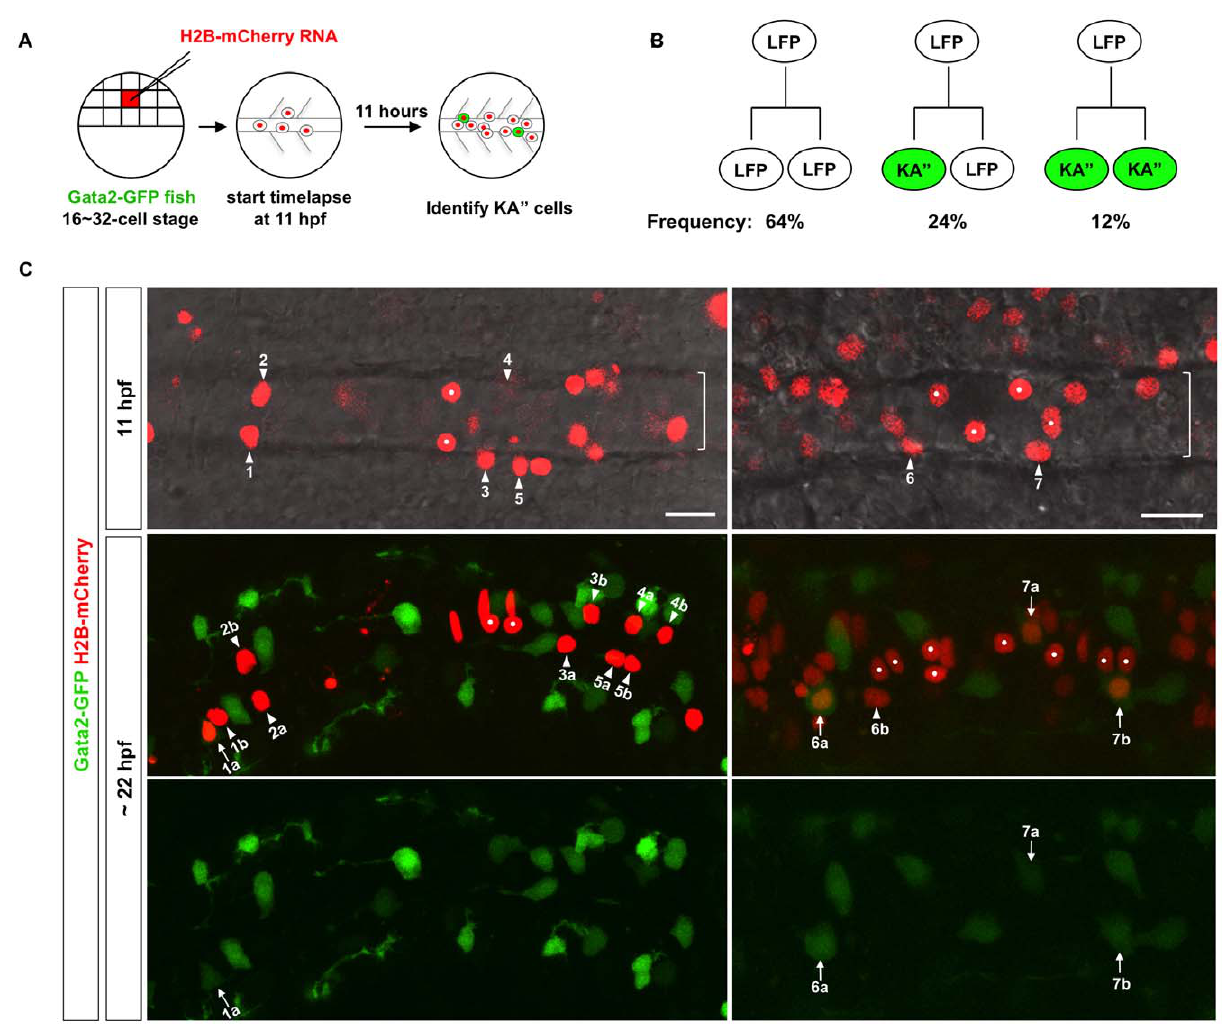
Figure 2. Lineage analysis of the LFP domain. (A) Schematic drawings of scatter labeling and time-lapse imaging. Gata2-GFP fish were injected with H2B-mCherry mRNA (red) into a single blastomere at 16- to 32-cell stage. Scatter labeled embryos with nuclear mCherry expression (red) were imaged in the dorsal view starting at 3-somite stage (11 hpf) for about 11 hours. At the end of the time-lapse, an image with both the green and red channels was acquired to identify Gata2-GFP -expressing KA 0 cells (green). (B) Observed division patterns in the LFP domain. Of a total of 25 cell divisions tracked, 16 were LFP/LFP divisions, 6 were KA 0 /LFP divisions, and 3 were KA 0 /KA 0 divisions. KA 0 cells (green) were identified base on the expression of Gata2-GFP reporter. (C) Gata2-GFP fish (green) was scatter labeled by H2B-mCherry (red) and imaged from 11 hpf for about 11 hours. Two examples are shown. Top panel: merged images with both the red channel and the bright field of a single optical slice at the start of the movie at 11 hpf. The underlying notochord (brackets) is visible but out of focus. Middle and bottom panels: the merged image with both green and red channels and the green channel alone of a confocal projection at the end of the movie around 22 hpf. KA 0 cells (arrows) can be distinguished from LFP cells (arrowheads) based on the expression of Gata2-GFP (green) at 22 hpf. Medial floor plate cells are indicated by white dots. Lineage related cells confirmed by cell tracking are indicated (also see Figure S1 and Video S1). For example, cell 1 generates a KA 0 cell (cell 1a) and an LFP cell (cell 1b). Of the 7 examples shown here, cells 1 and 6 undergo KA 0 /LFP divisions, cell 7 undergoes KA 0 /KA 0 division, and cells 2–5 divide symmetrically giving rise to two LFP cells (LFP/LFP divisions). Note that cells 4 and 6 are more dorsally located and therefore not in focus in images at 11 hpf (top panels). Scale bars: 20 m